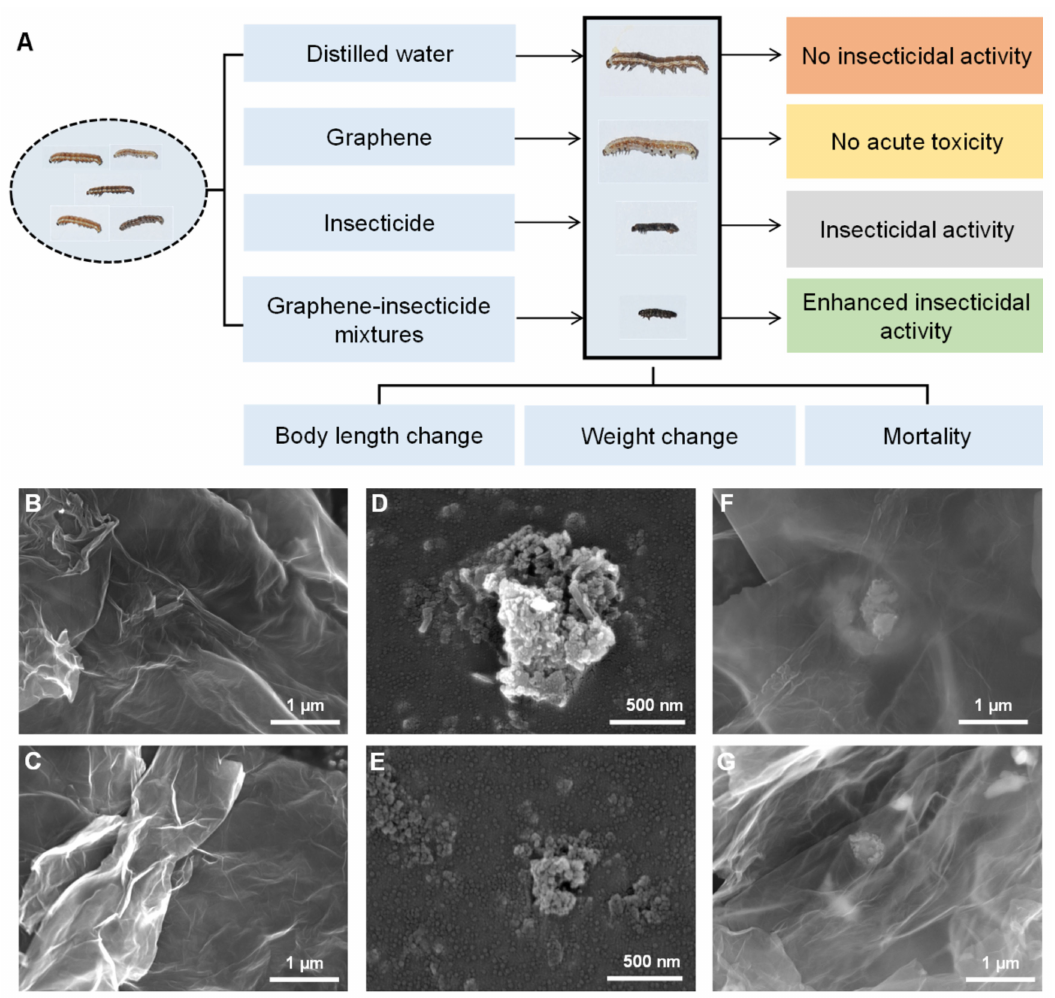
Figure 1. ( A ) Workflow of the synergistic mechanism study of graphene-delivered insecticide. Characterizations of graphene, insecticides, and formulated graphene–insecticide mixtures: SEM images of ( B , C ) graphene, ( D ) Cyh, ( E ) Cyf, ( F ) Cyh/G (3/1), and ( G ) Cyf/G